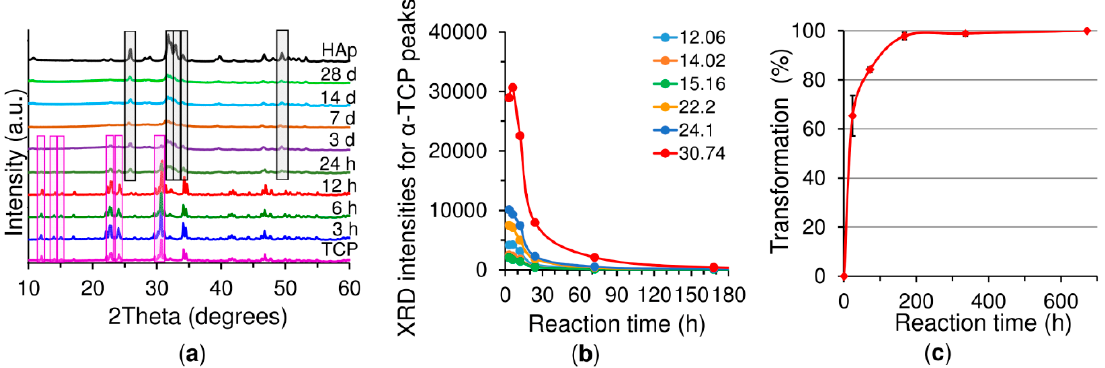
Figure 5. Crystalline phase analysis of the 20 w / v % polymer/CPC over a reaction time of 3 h to 28 days at a fixed L/P ratio of 0.5 g · g − 1 at 37 ◦ C. ( a ) Representative XRD patterns, apatite was detected as soon as after 24 h (grey plotted part) and α -TCP was detected up to the third day of reaction (purple plotted part). ( b ) Intensity of the XRD peaks at 12.06; 14.02; 15.16; 22.20; 24.10 and 30.74 ◦ (2 θ ). ( c ) The total average transformation of α -TCP to calcium deficient hydroxyapatite (CDHA) while neglecting negative values at the 3, 6 and 12 h setting times.